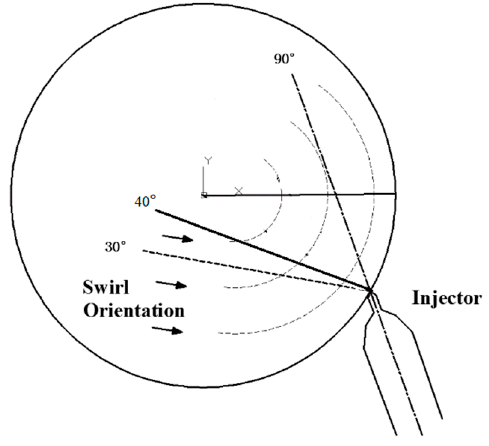
Figure 5. Injection angles used in HFO and diesel simulations.